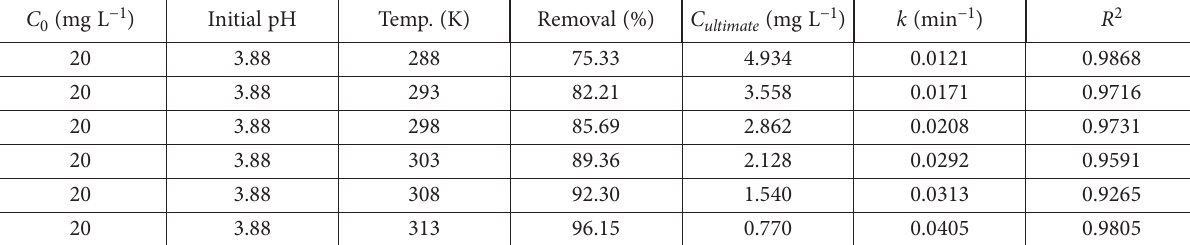
Table 1. Fitted data for the removal of Cr(VI) by PPN using a two-parameter pseudo-first-order decay kinetics model